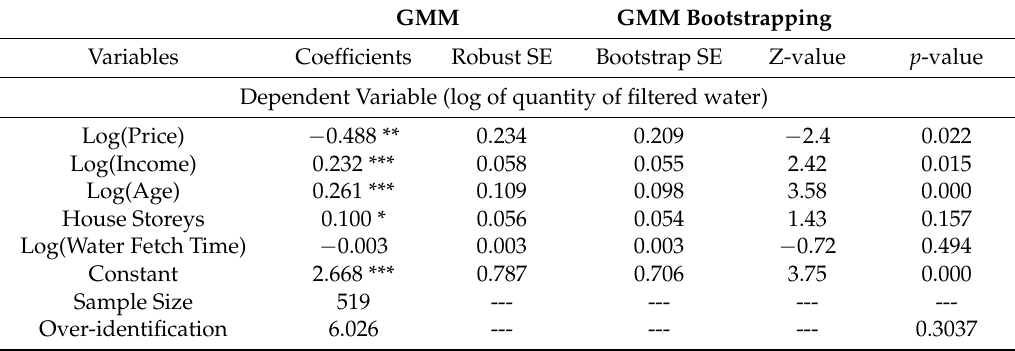
Table A4. Generalized method of moment estimation of residential water demand (filtered). GMM GMM